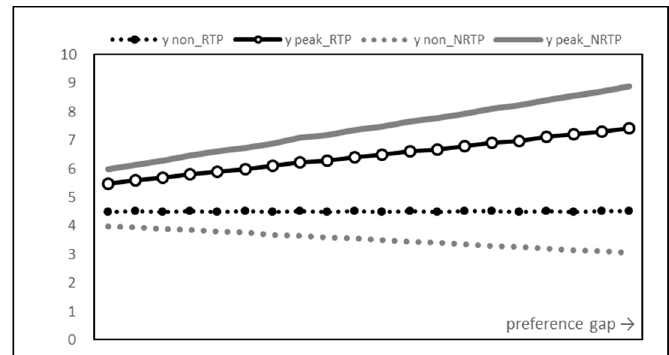
Figure 4. Energy consumption graph.